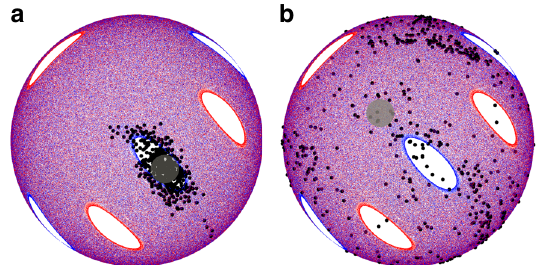
Fig. 4 In fl uence of collisional diffusion. Comparison of the motion of 100 tracer particles under the (57°, 57°) protocol with collisional diffusion and initially located (gray circle) a within an island and b outside an island. After twelve iterations of the protocol, most of the particles initially located within the island ( a ) remain, while particles initially located outside the island ( b ) are distributed over the entire hemisphere due to chaotic mixing